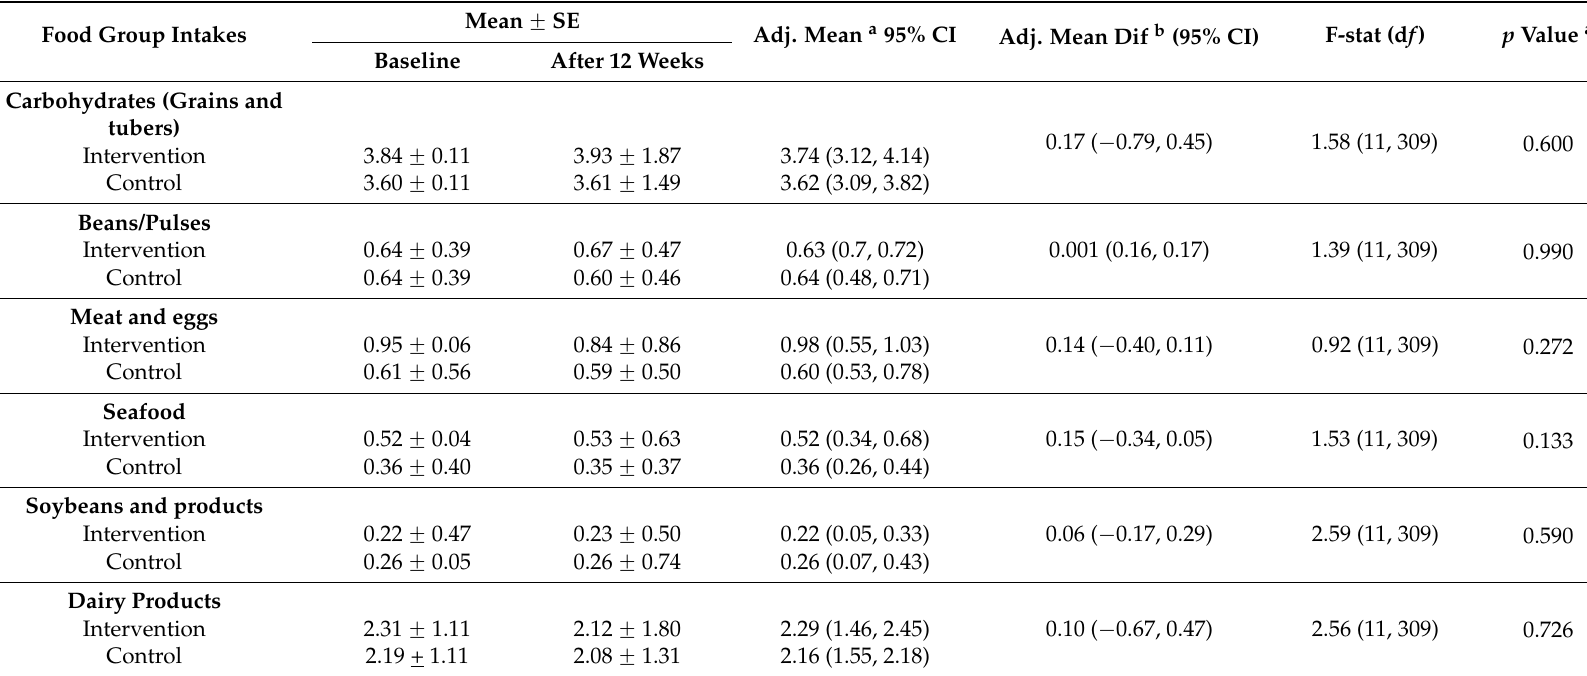
Table 5. Mean frequency scores of food group intakes in intervention ( n = 175) and control ( n = 178) group and ANCOVA analysis after controlling for potential